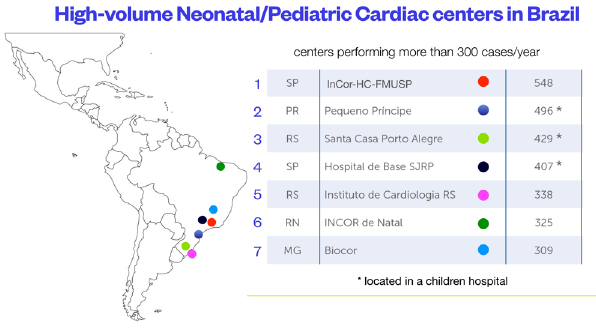
Fig. 2 - Location and caseload of the largest pediatric cardiac